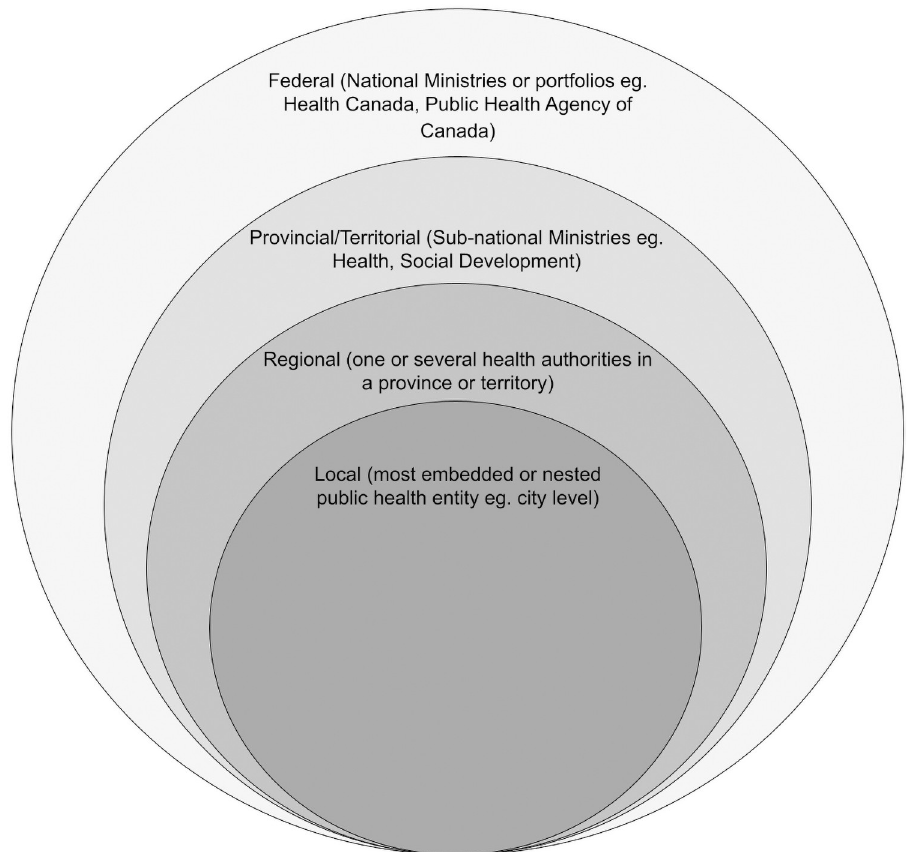
Fig 1. Local public health units in nested public health governance.